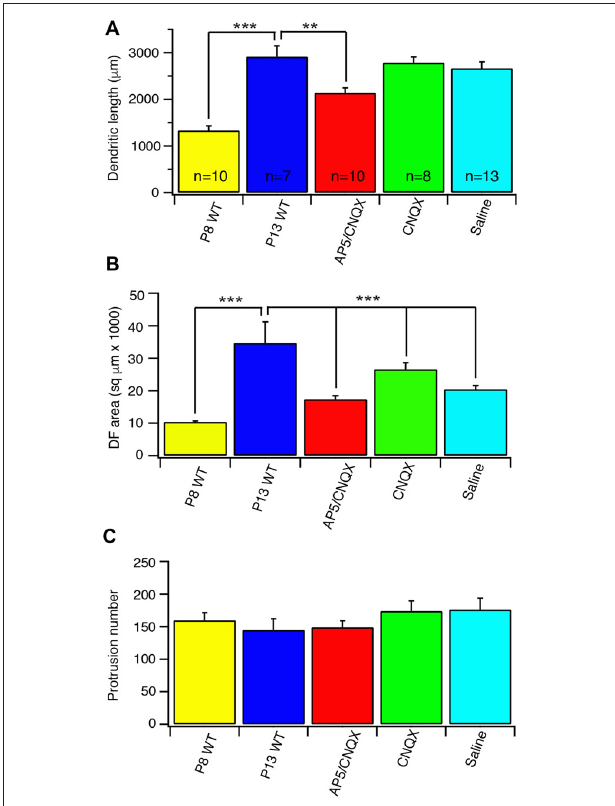
FIGURE 4 | Blockage of glutamate receptor activity retarded the developmental refinement of J-RGC dendrites. The dendritic pattern of J-RGCs was quantitatively analyzed at the age of P13 of JamB-CreER:Thy1-YFP mice with intraocular injection of CNQX or PA5+CNQX for 4 days from P9 to P12. The results were compared with that of JamB-CreER:Thy1-YFP mice at the ages of P8 (P8 wild type (WT): 3 mice, 10 cells) and P13 (P13 WT: 2 mice, 7 cells) without injection and the mice with 4 days intraocular injection of saline. (A) The average total dendritic length of J-RGCs at ages of P8 (P8 WT), P13 (P13 WT), P13 mice treated with intraocular injection of CNQX (CNQX: 3 mice, 8 cells), CNQX+AP5 (AP5/CNQX: 3 mice, 10 cells) or saline (Saline: 3 mice, 13 cells). (B) The average sizes of DF of J-RGCs of the same five groups of mice as shown in (A) . (C) The average number of dendritic protrusions of J-RGCs of the same five groups of mice as shown in (A) . ∗ P < 0.05; ∗∗ P < 0.01; and ∗∗∗ P < 0.001.